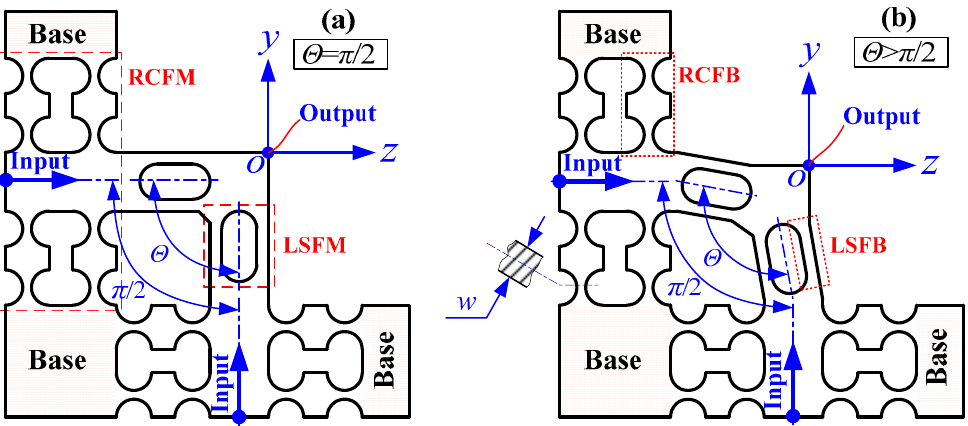
Figure 1. Basic principle of the developed two-degree-of-freedom (2-DOF) pseudo-decoupled compliant mechanism (PDCM). ( a ) Traditional orthogonal configuration; ( b ) Novel non-orthogonal configuration.